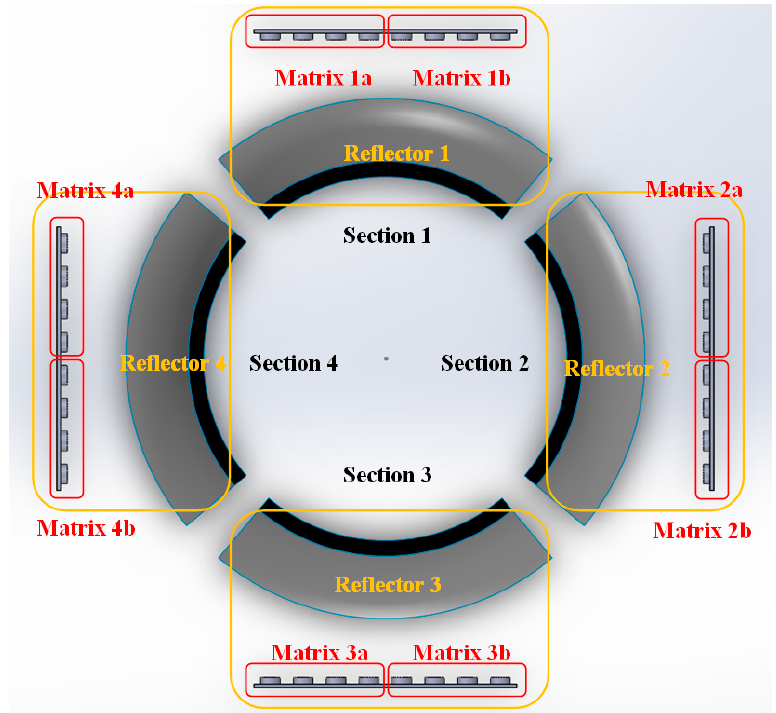
Figure 9. The division of the light-optical system into sections.